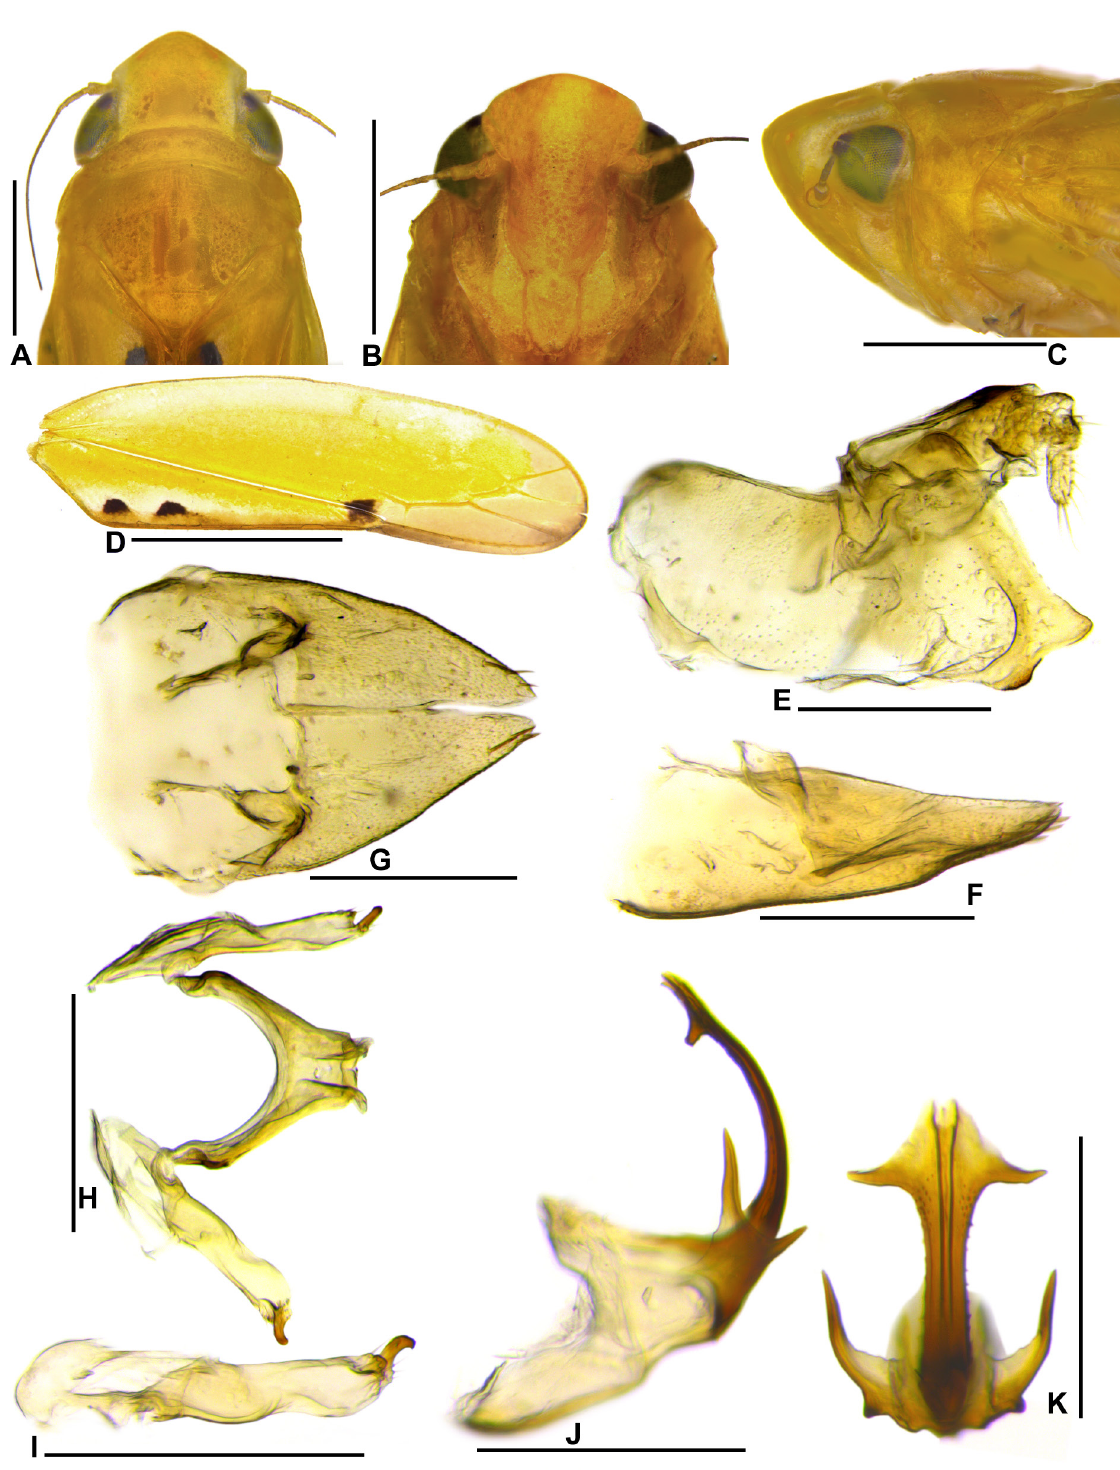
Fig. 7. Takiyaella daniela gen. et sp. nov., ♂, holotype (DZRJ-AUCH #244). A . Head and thorax, dorsal view. B . Head, frontal view. C . Head and thorax, lateral view. D . Forewing. E . Pygofer and anal tube, lateral view. F . Valve and subgenital plate, lateral view. G . Valve and subgenital plate, ventral view. H . Styles and connective, dorsal view. I . Style, lateral view. J . Aedeagus, lateral view. K . Aedeagus, caudal view. Scale bars: A–C = 1.0 mm; D = 2.0 mm; E–I = 0.5 mm; J–K = 0.4